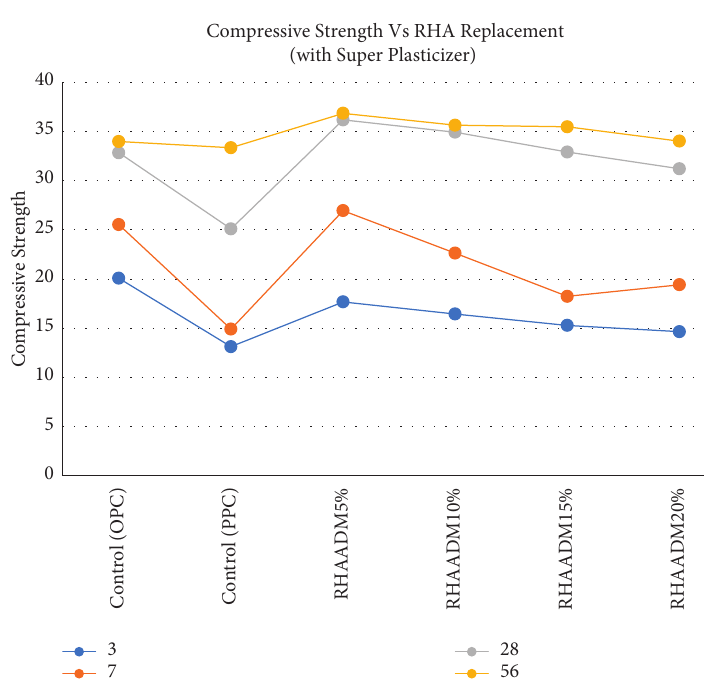
Figure 7: Compressive strength vs. RHA replacement for concretes with the addition of superplasticizing